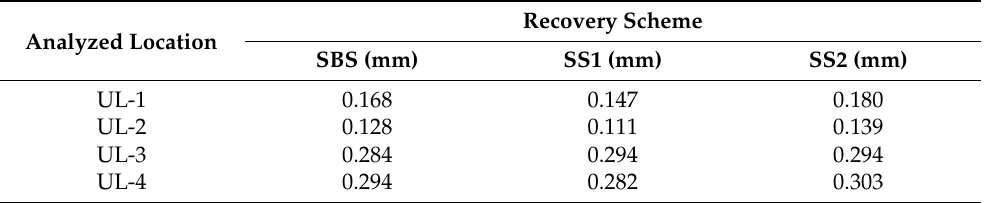
Table 4. Sill pillar recovery induced displacement at upper levels. Analyzed